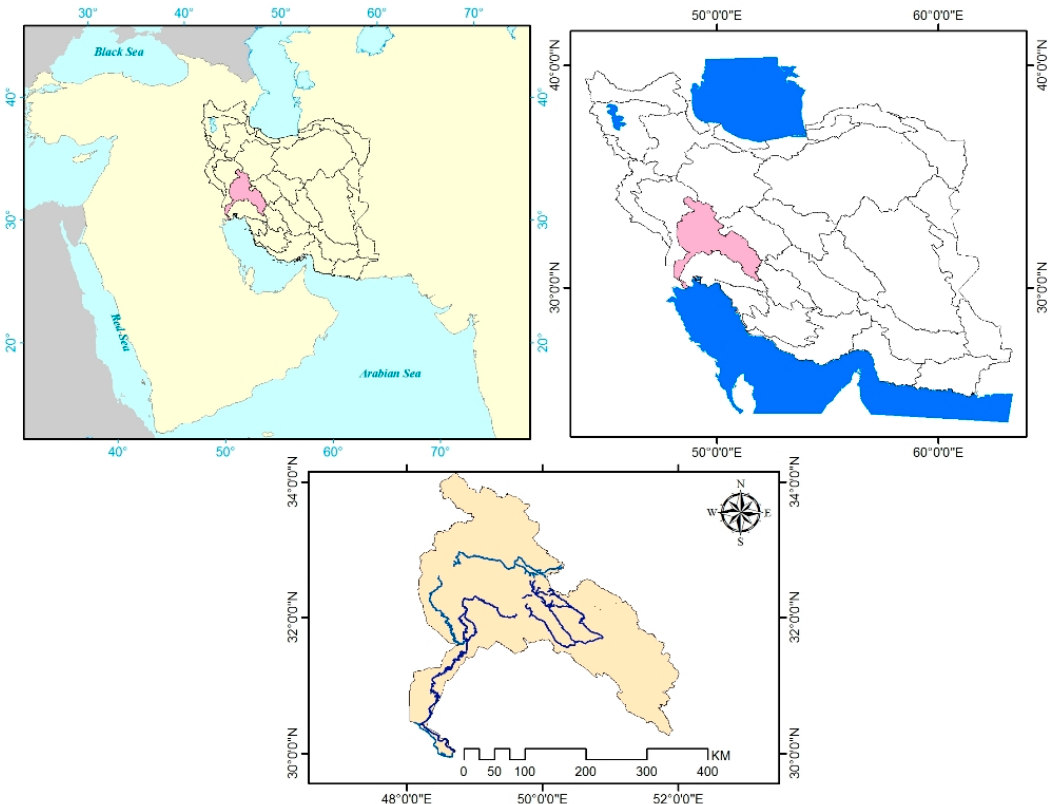
Figure 1. General location of the Karoon River Basin in Iran.